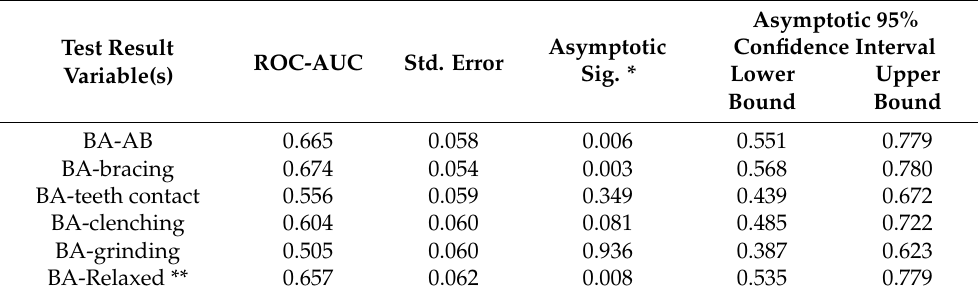
Table 2. Summary of the ability of the BruxApp conditions to discriminate between patients with and without possible AB